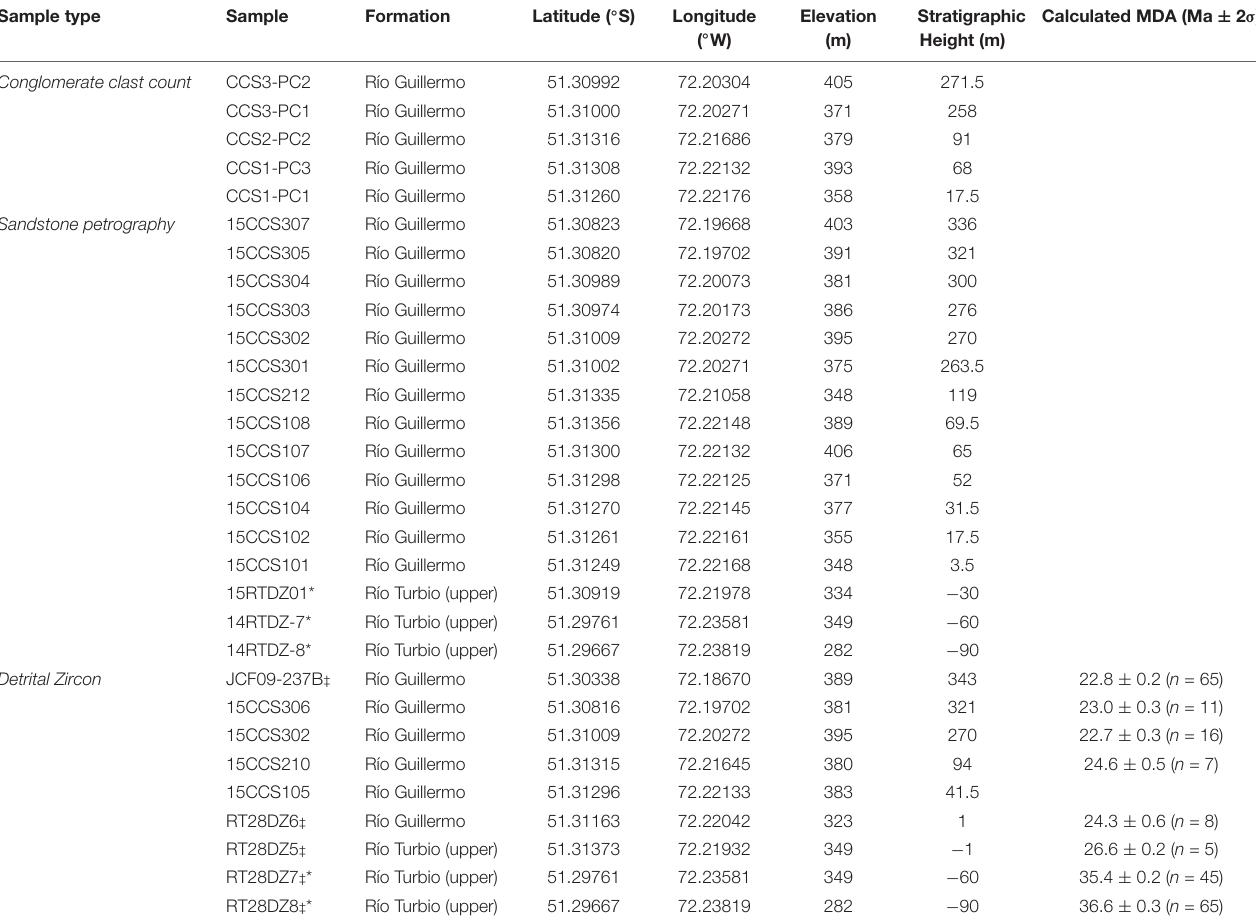
TABLE 1 | Locality information for clast counts, sandstone petrography, and detrital zircon U-Pb LA-ICPMS samples. Sample